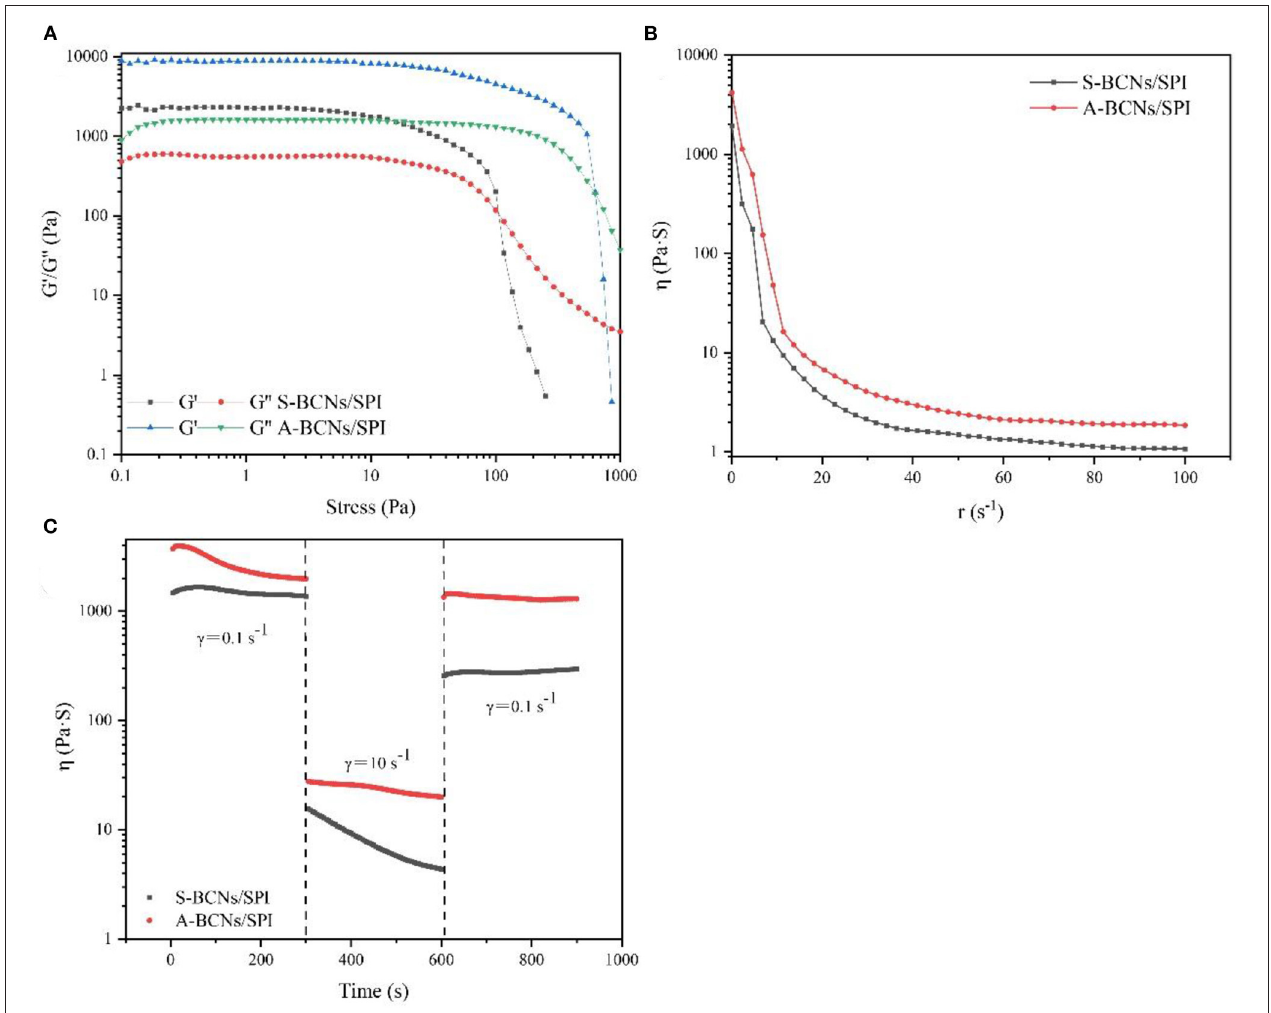
FIGURE 3 | Stress sweeps (A) , apparent viscosity (B) , and thixotropic recovery (C) for BCNs/SPI colloidal particles prepared by using different self-assembly